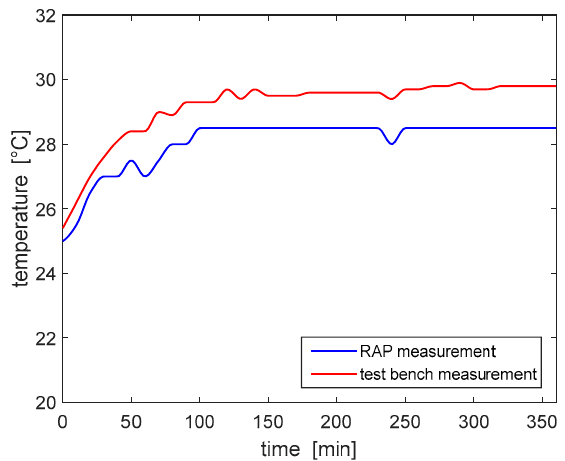
Figure 11. Comparison of temperature values read by the RAP and the test bench.